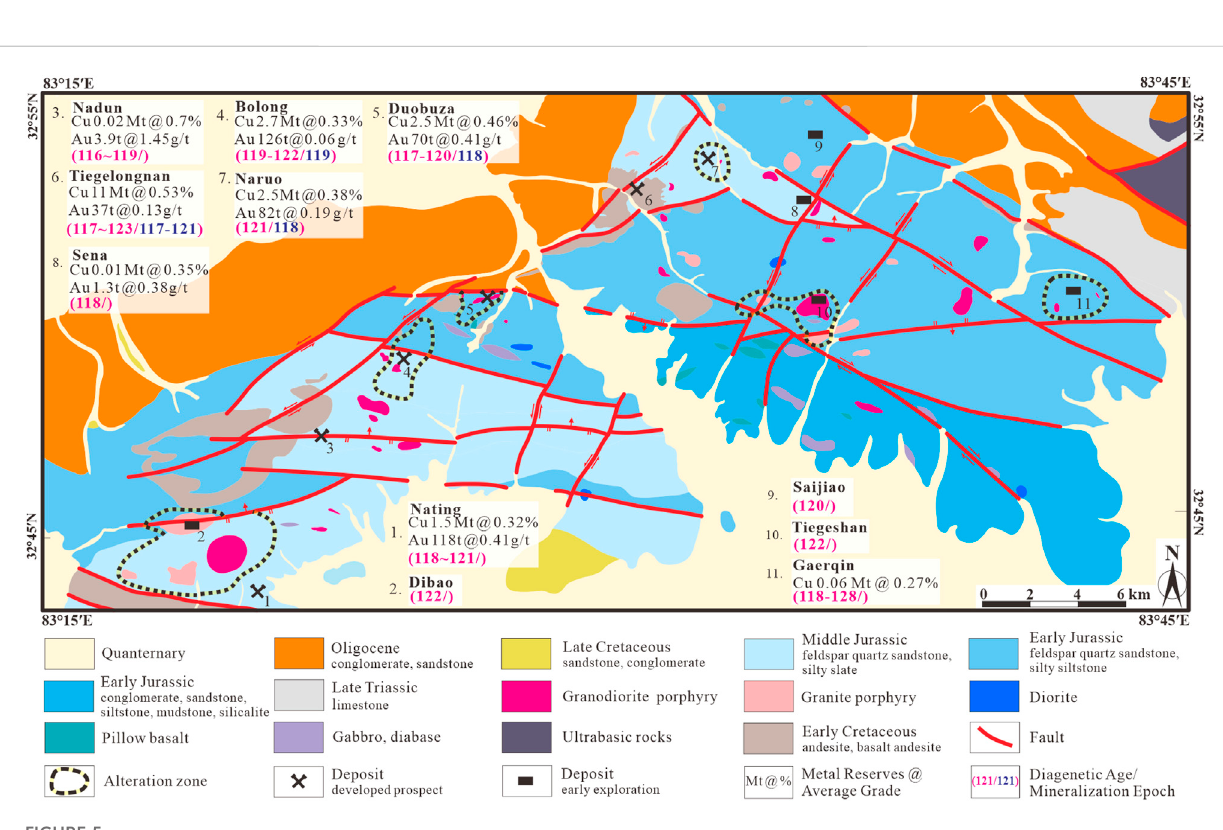
Frontiers in Earth